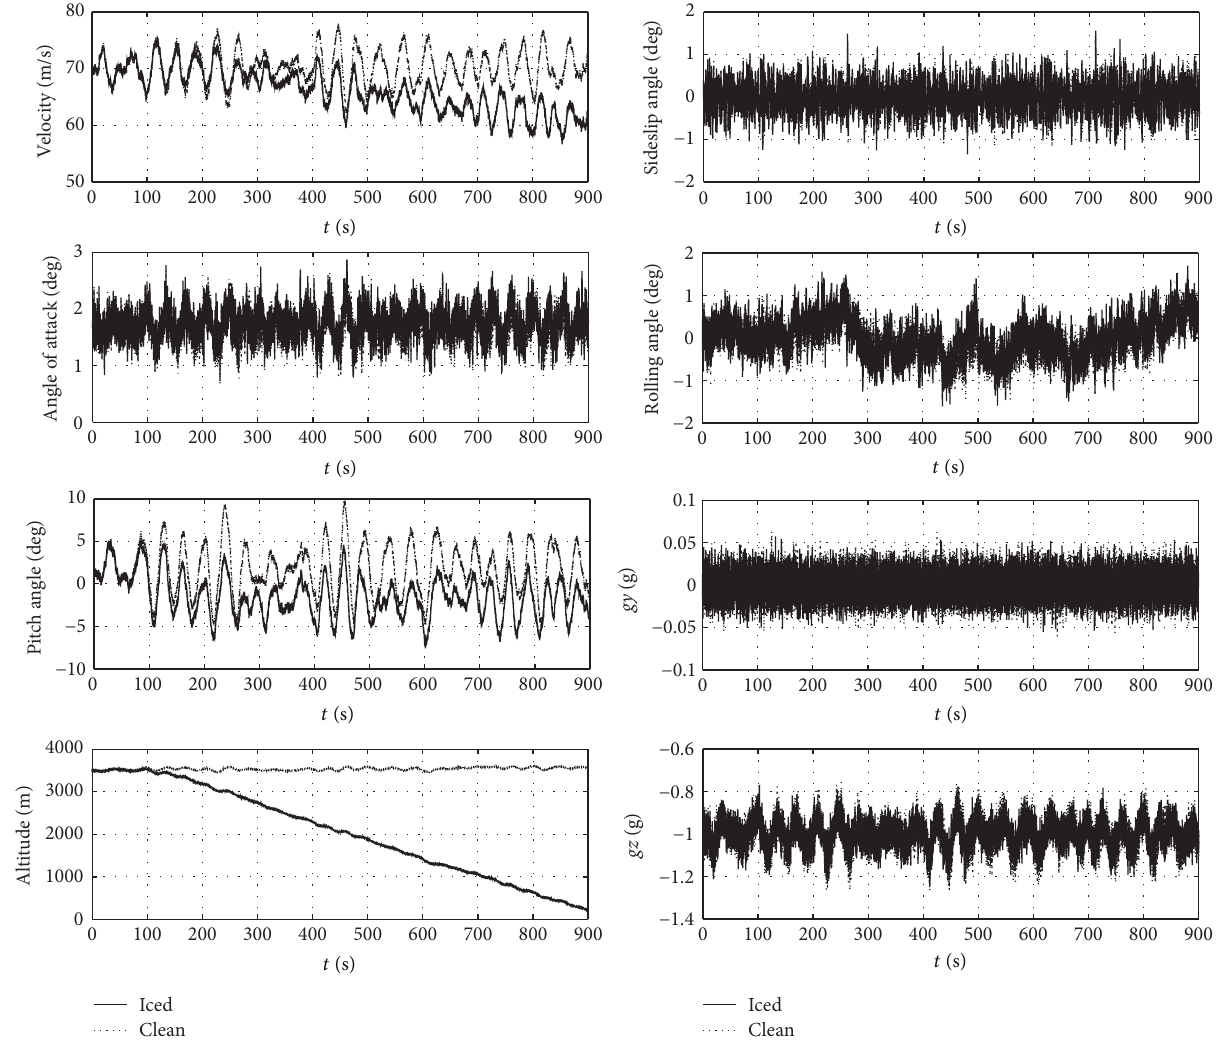
Figure 2: Aircraft response, clean, and wing-tail severe